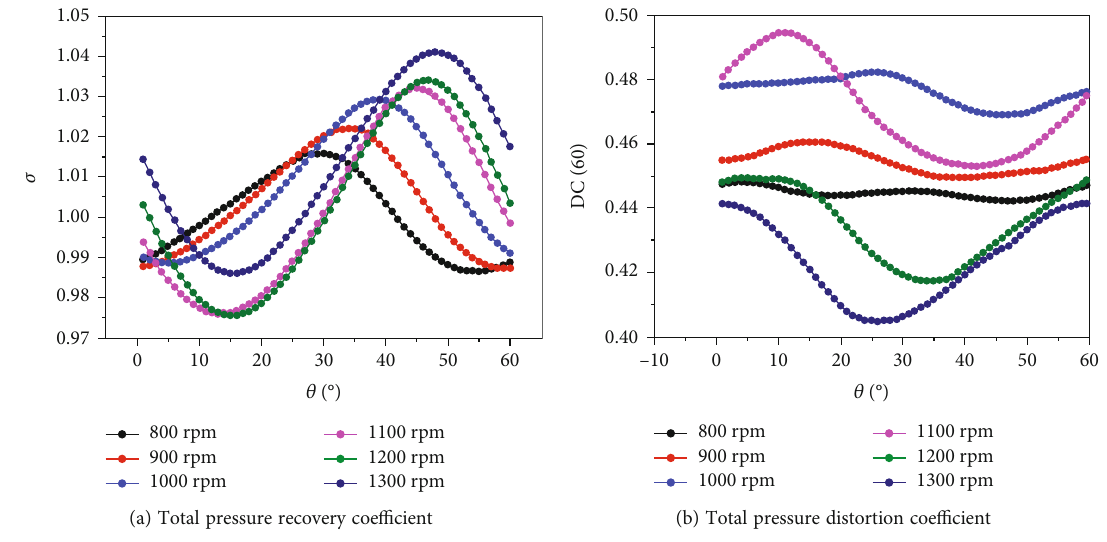
Figure 15: Total pressure recovery coe ffi cient and distortion coe ffi cient vary with θ . Table 3: Total pressure recovery coe ffi cient and distortion coe ffi cient for di ff erent cases.